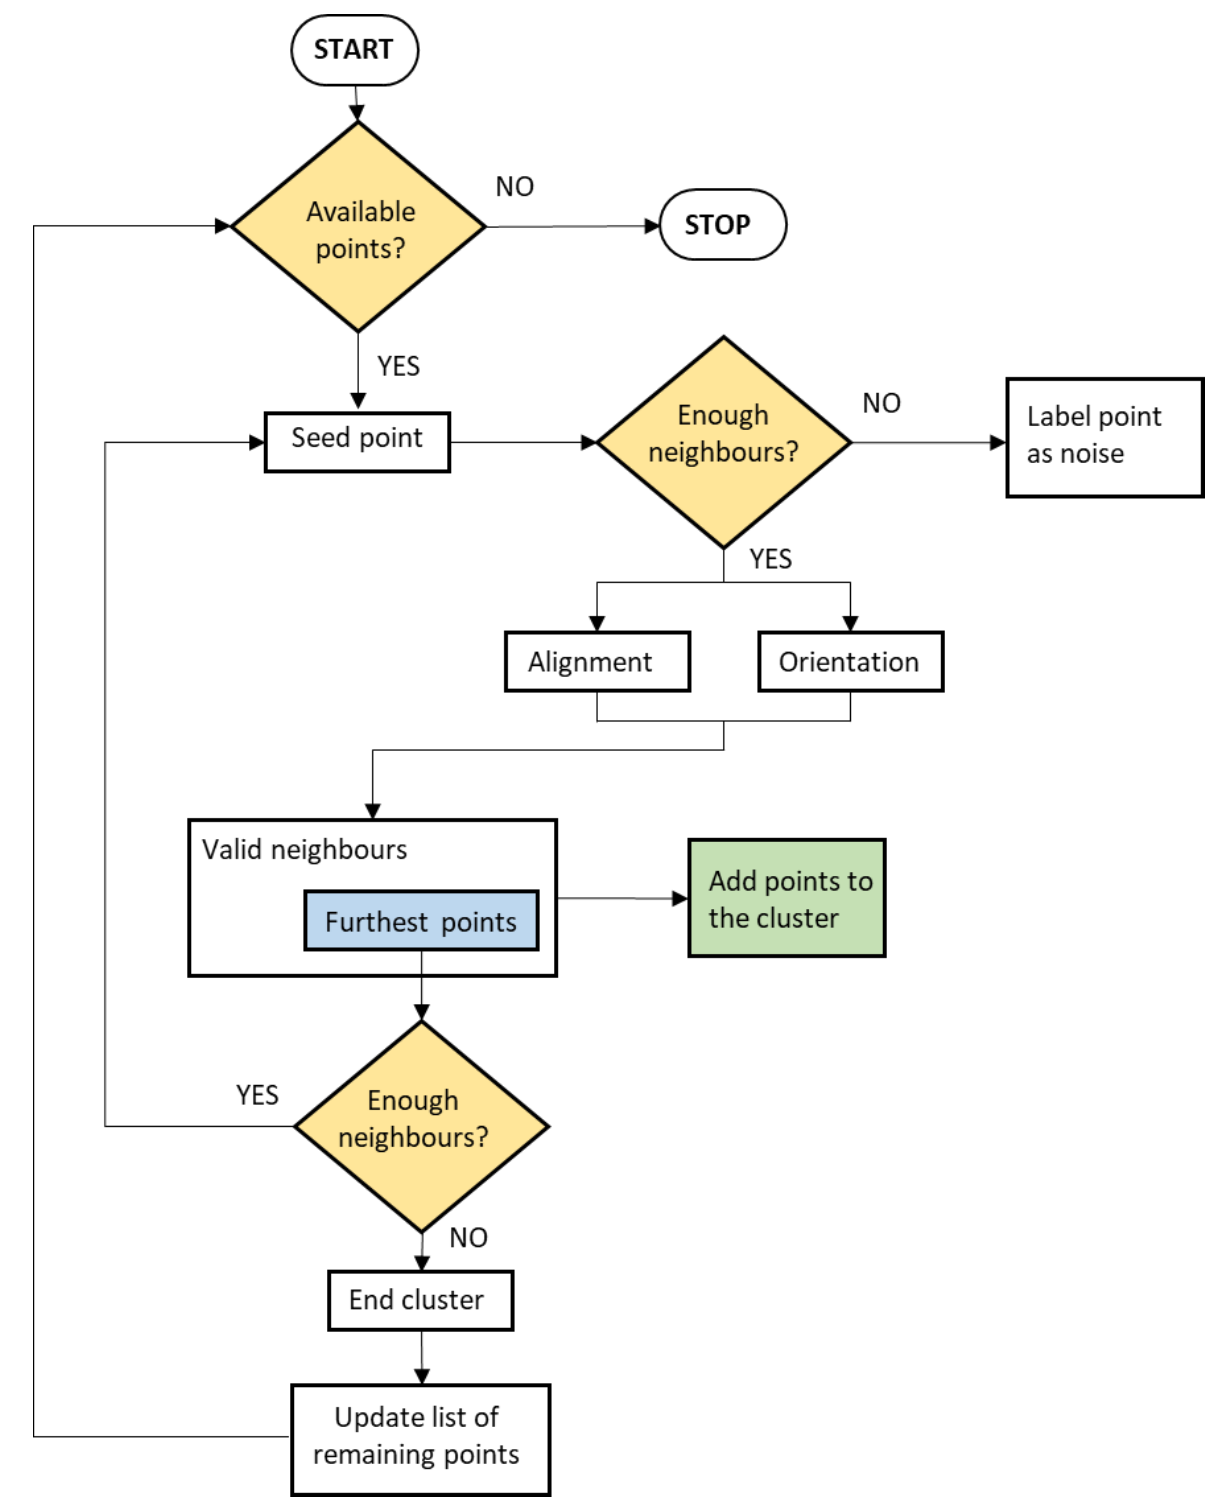
Figure 4. Region-growing algorithm for crack point clustering.